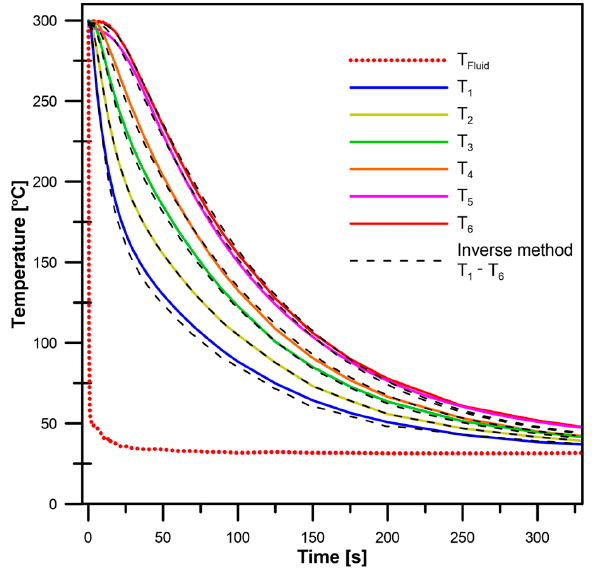
Figure 18. Water temperature, measured temperature histories, and those identified by the AMI method.